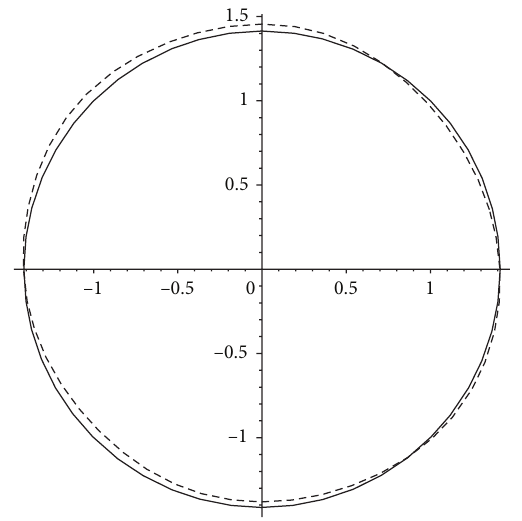
Figure 2: The periodic orbit 𝑢 2 + V 2 = 2 for 𝜀 = 0 and the analytical and numerical approximations of the limit cycle for 𝜀 = 1/20 of system (38).